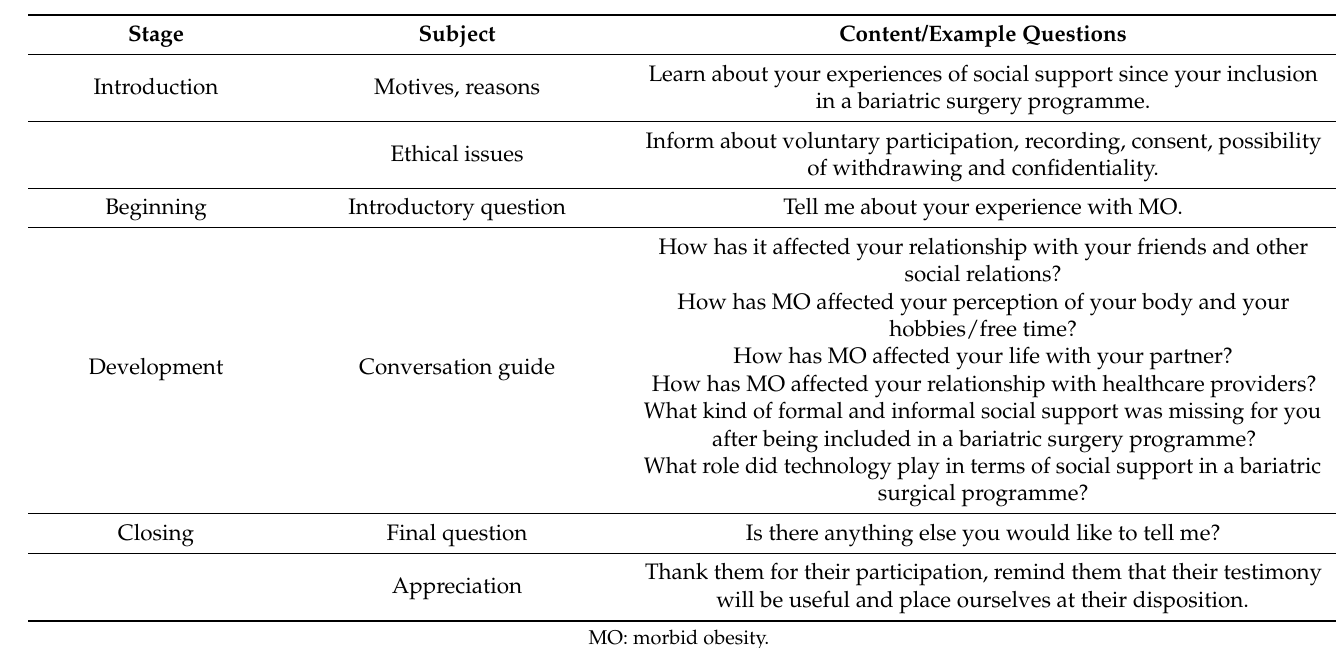
Table 2. Interview